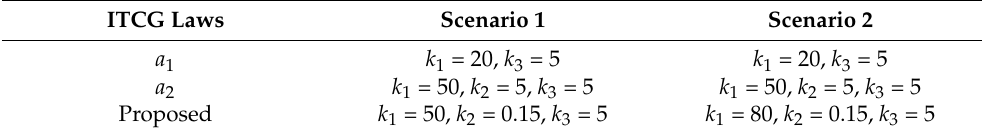
Table 4. Simulation coefficients under different ITCG laws.